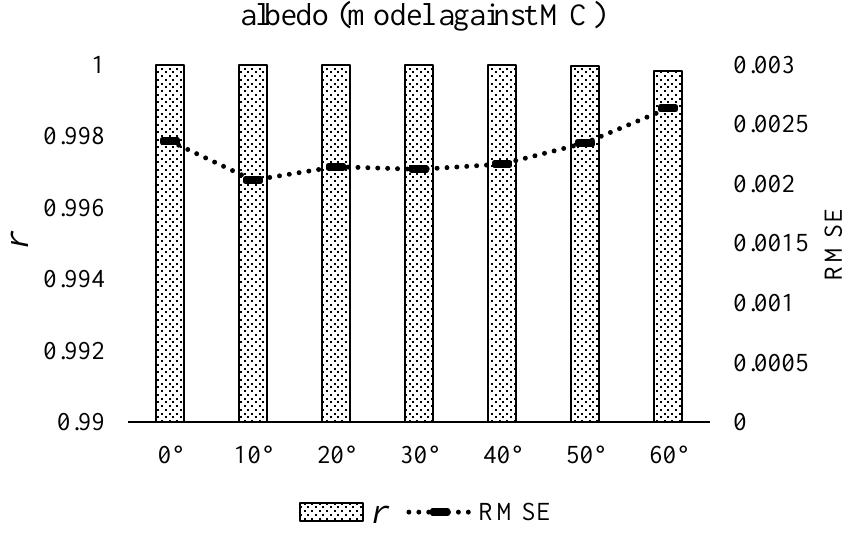
Figure 11. Pearson’s correlation coefficient ( r ) (bar graph) and root mean square error (RMSE) (line chart) between the model-simulated and MC-simulated BSA of continuous vegetation under different solar zenith angles at the green band (530